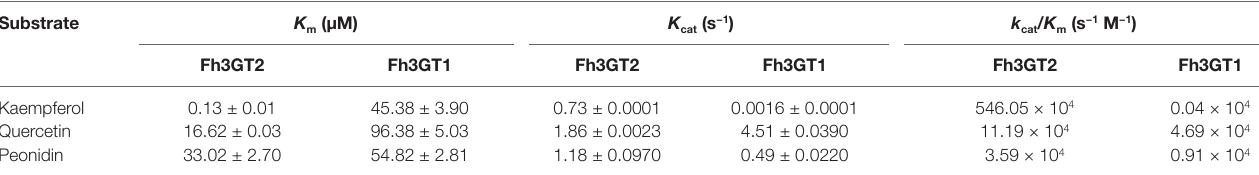
TABLE 2 | Kinetic parameters of recombinant Fh3GT2 and Fh3GT1.